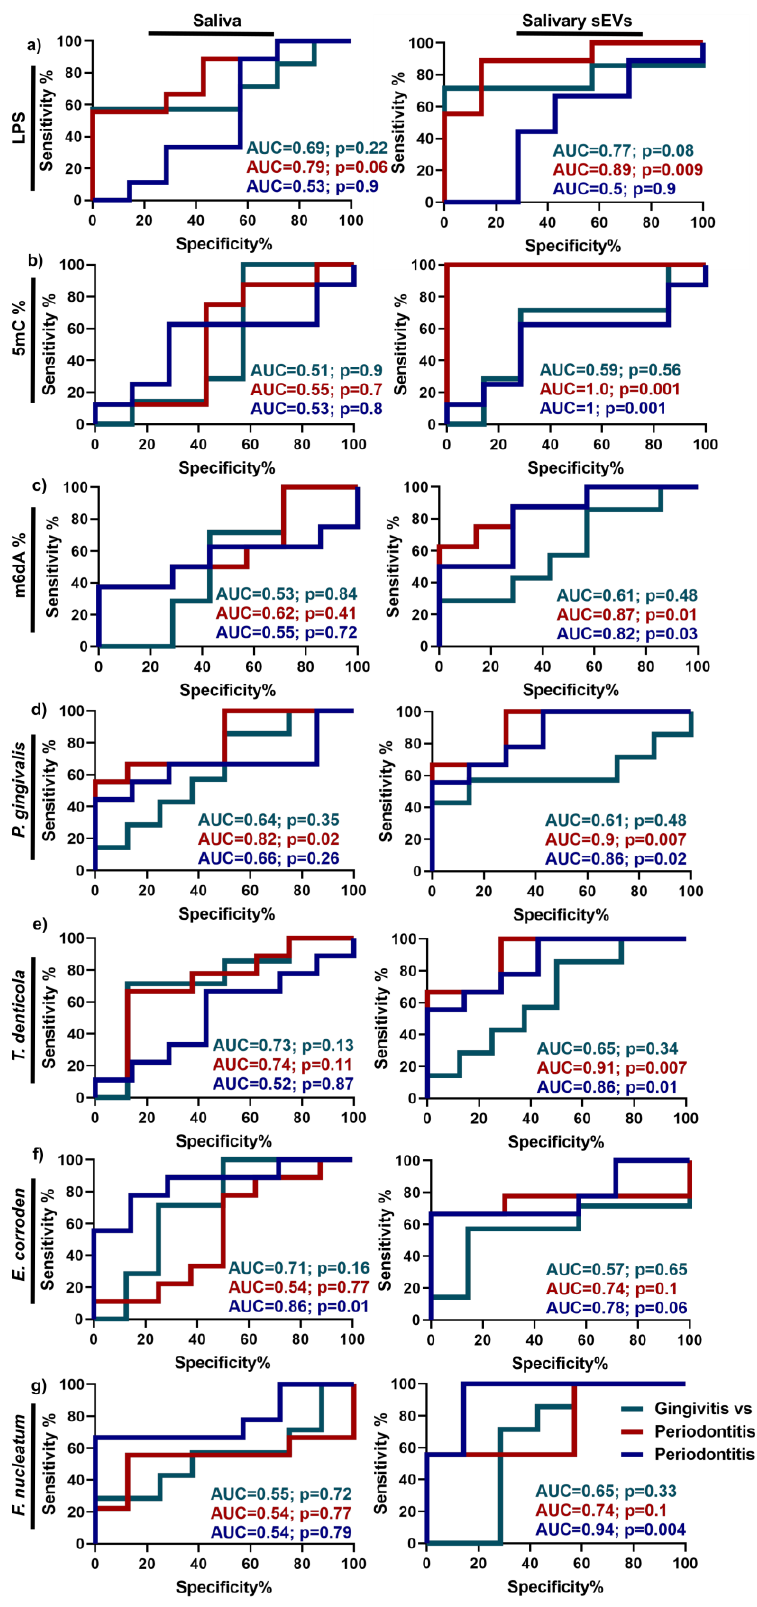
Figure 4. Discrimination power of up-regulated LPS ( a ), global 5mC ( b ), m6dA ( c ), P. gingivalis ( d ), T. denticola ( e ), E. corrodens ( f ) and F. nucleatum ( g ) in saliva and salivary sEVs from healthy, gingivitis and periodontitis patients by using receiver operating characteristic (ROC) curves and area under the curve (AUC).